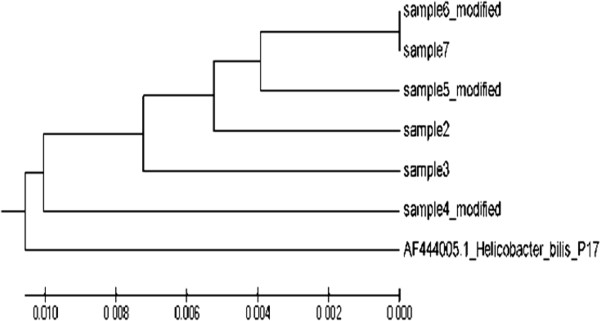
Helicobacteraceae DNA was detected with Single PCR in all the colonic biopsies: Evolutionary relationships of taxa for
helicobacter bilis
the evolutionary history was inferred using the UPGMA, Kimura 2-parameter and MEGA5 methods.